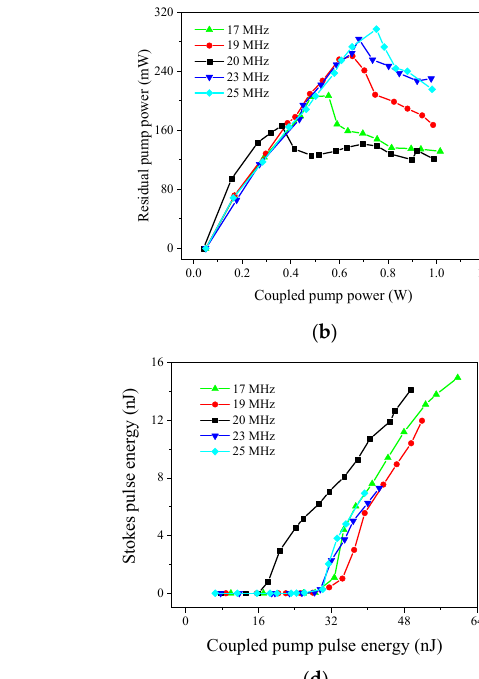
pulse energy in different repetition frequency.